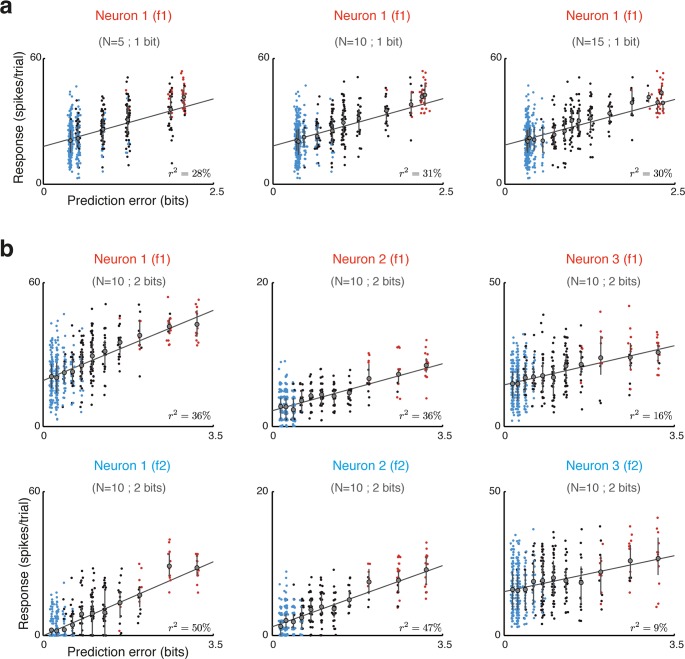
Neuronal representation of prediction error in the oddball paradigm.(a) Spike counts of single trial responses of one neuron to one of the two frequencies with which it was tested, plotted as a function of the expected prediction error for the same trial. The prediction errors were computed using optimal reduced representations at three past durations (N = 5, N = 10 and N = 15) with a complexity of 1 bit. A small amount of jitter was added to the x coordinate for visualization purposes only. Colors correspond to the different experimental blocks (p = 10% in red; p = 50% in black; p = 90% in blue). Error bars indicate the mean and the 25th and 75th percentiles for each value of the prediction error. (b) Responses of three different neurons (plotted separately for the two tones, top and bottom panels) as a function of the expected prediction error for a past duration of N = 10 stimuli at a complexity of 2 bits. Responses of the top leftmost panel belong to the same neuron shown in panel a.